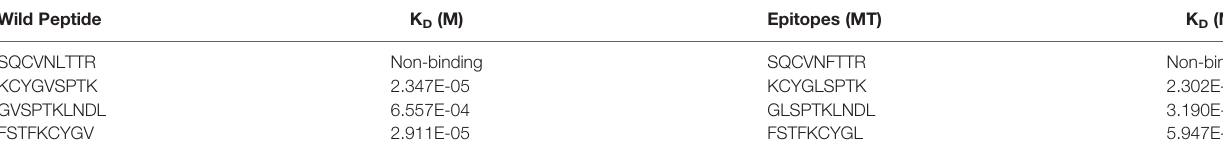
TABLE 5 | Physicochemical properties of candidate epitopes. Candidate Epitopes